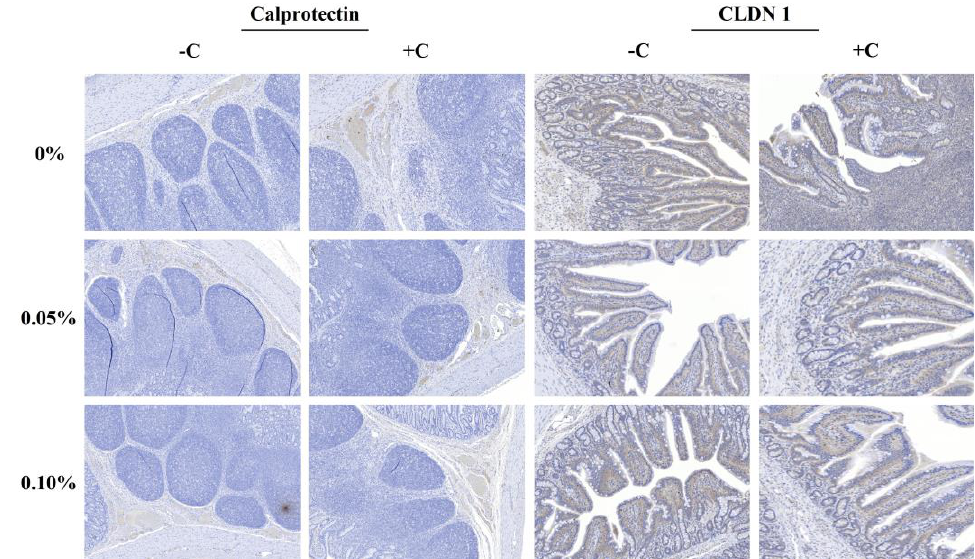
Figure 4. Immunohistochemistry staining of the protein expression for Claudin-1 and Calprotectin of the ileum tissue. Positive staining indicated by a brown precipitate in cells.